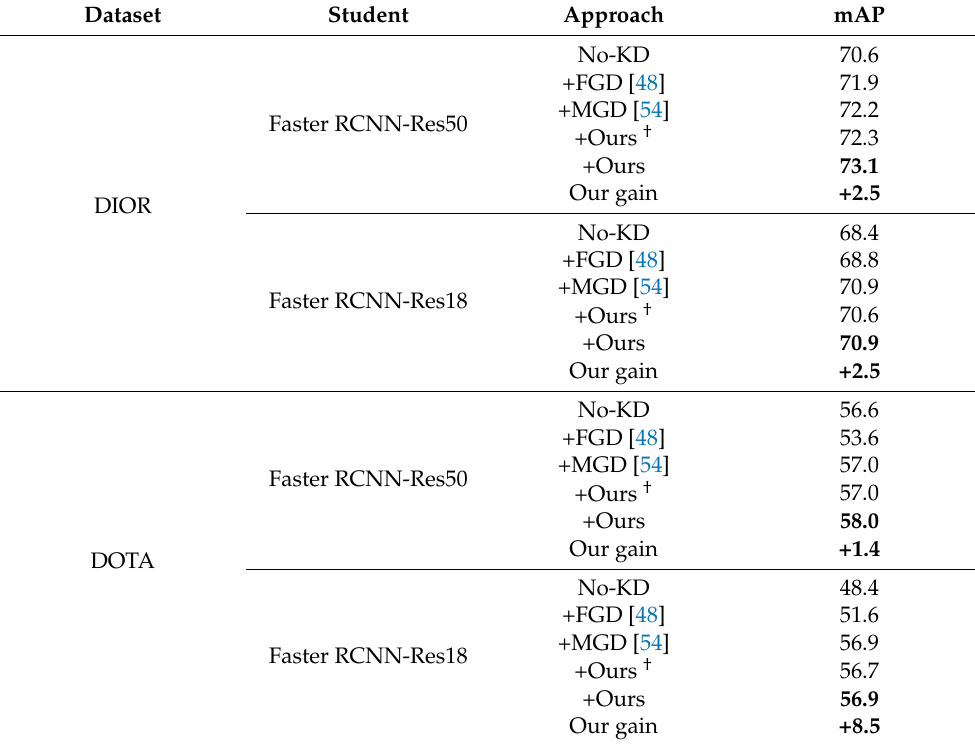
Table 3. Comparison with state-of-the-art distillation approaches. The best results are marked by bold text. † means without multi-teacher